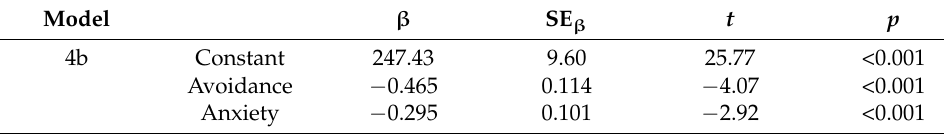
Table 8. Model for subgroup cases with high level of mindfulness. Model